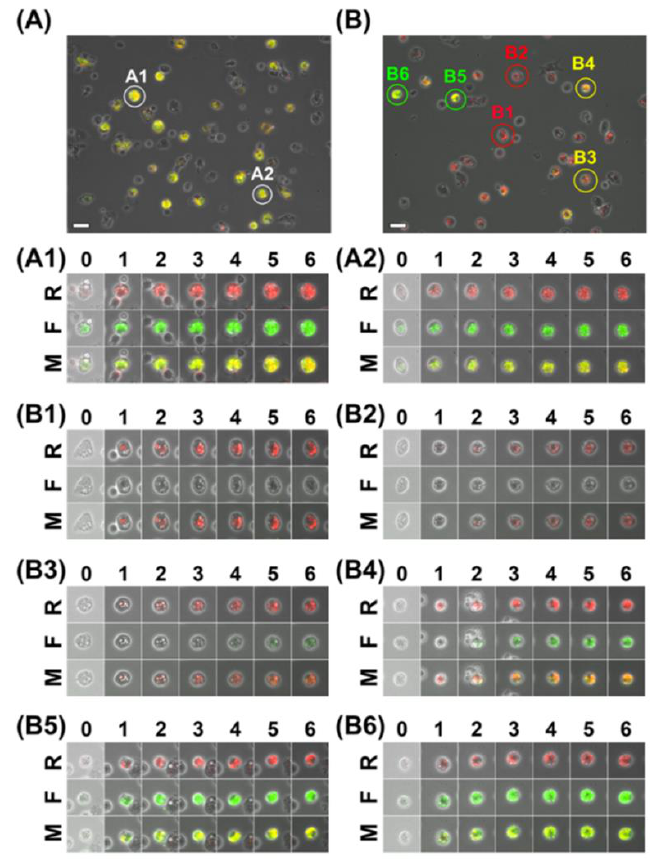
Figure 2. Single-cell dual-particle images showing macrophage uptake of fluorescent organosilica nanoparticles surface functionalized with PEG. The macrophages were incubated with a mixture of Flu and Rho ( A ) or with a mixture of Flu-PEG30K and Rho ( B ). The fluorescence images of Rub (R), Flu, or Flu-PEG30K (F) and merged images (M) of single cells are shown, from 0 to 6 h. The scale bars represent 40 μm. ( A1 , A2 ) Cells showed similar uptake of Flu and Rho. ( B1 , B2 ) Cells showed uptake of Rho and almost no uptake of Flu-PEG30K. ( B3 , B4 ) Cells showed uptake of Rho and a lower uptake of Flu-PEG30K. ( B5 , B6 ) Cells showed a similar uptake of Flu, Rho, and Flu-PEG30K.